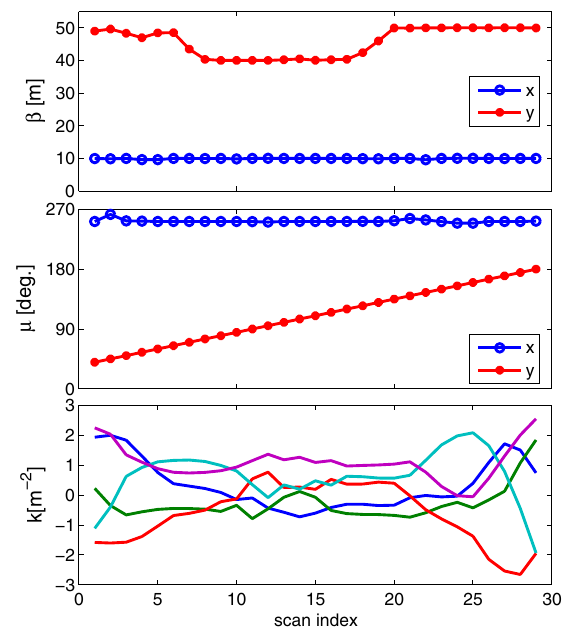
function at its position ( ≈ 15 m) is larger than at the second better longitudinal resolution. The dispersion kick gener-